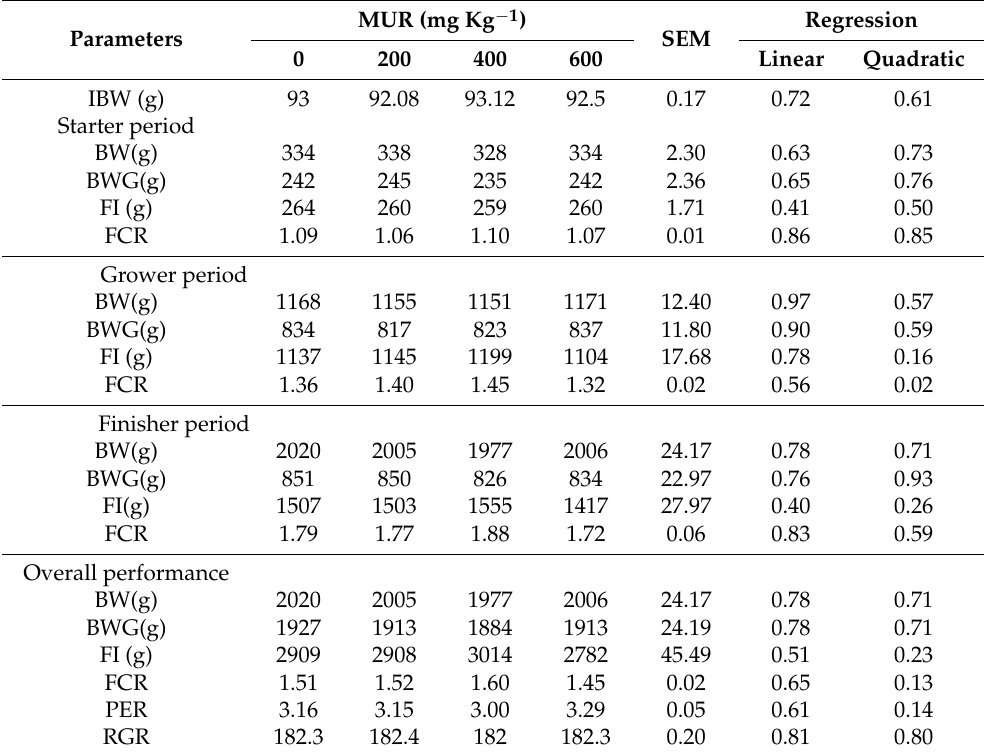
Table 2. The effect of MUR on the broiler chickens’